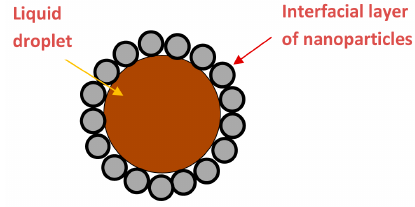
Figure 1. Droplet of a Pickering emulsion.